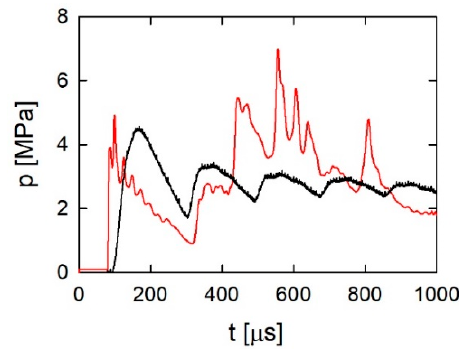
Figure 17. The changes in time of the pressure acting on the end of the chamber: black line: the results of measurements, red line: the results of calculations.